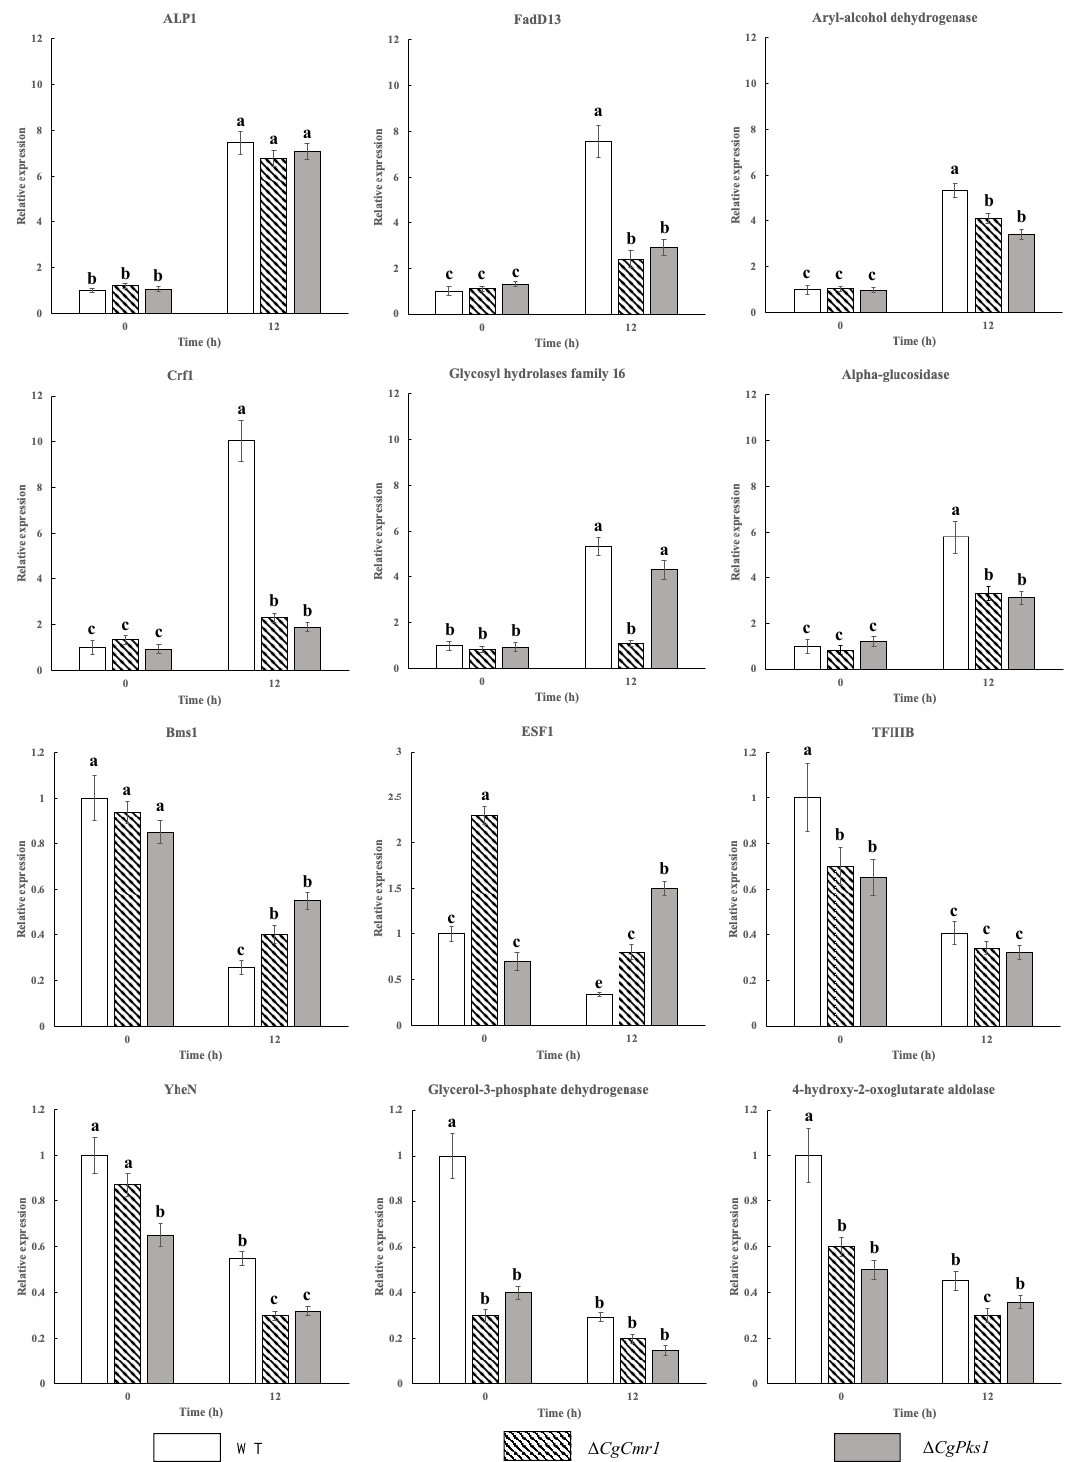
Figure 6. Results of the qRT-PCR analysis performed to validate key candidate DEGs in the wild-type (WT) control and Δ CgCmr1 and Δ CgPks1 mutants at 0 and 12 h. The qRT-PCR data represent the mean of three replicates. Bars indicate the standard error. Different letters indicate significant differences among treatments, as determined by Duncan’s test ( p <